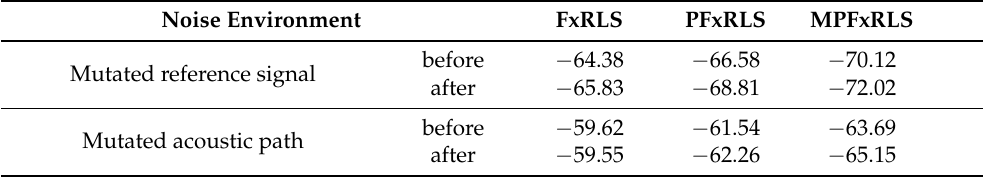
Figure 4. Tracking performance testing: ( a ) shows the result of changing reference signal. ( b ) shows the result of changing secondary path. Table 3. Steady-state MSE of FxRLS, PFxRLS and MPFxRLS for mutation noise environment